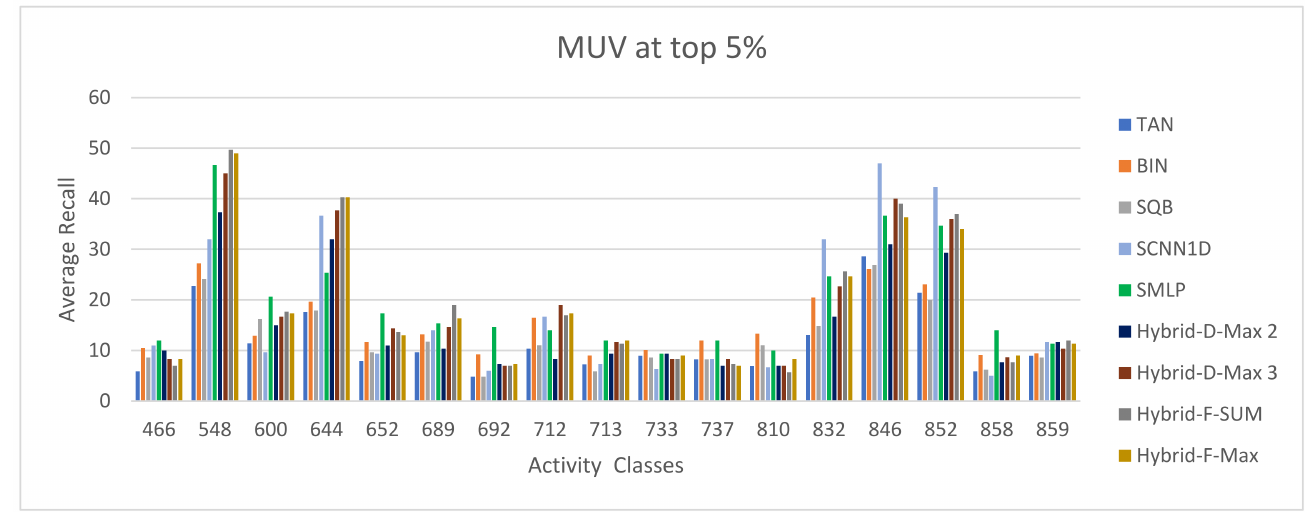
Figure 15. The comparison among methods for the average recall percentage at the top 5% in MUV.